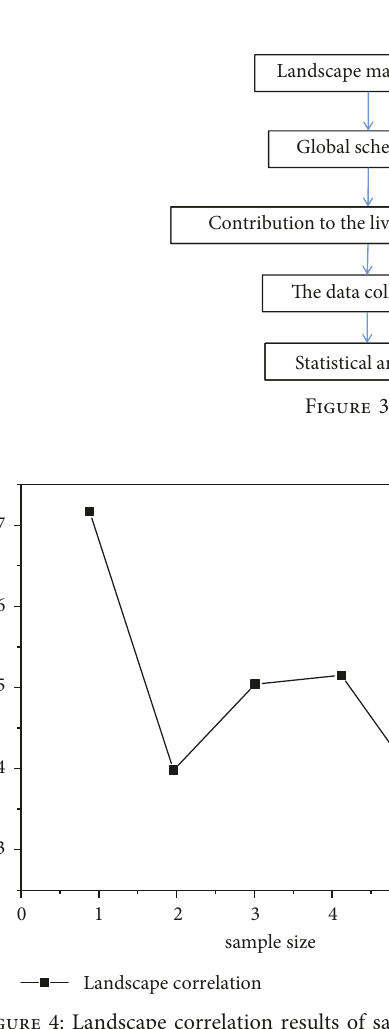
Figure 6: Contribution level results of sample pixels.